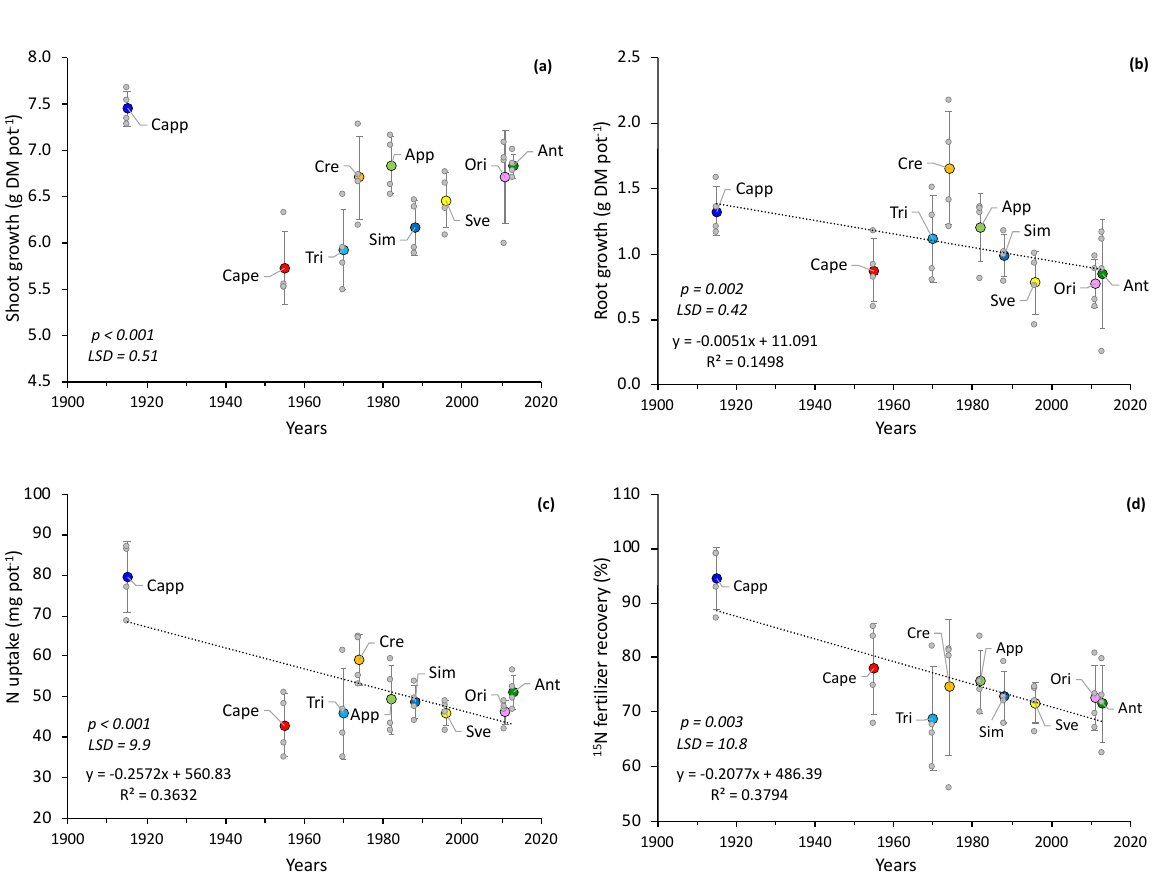
Figure 3. Relationships between shoot growth ( a ), root growth ( b ), N uptake ( c ), and 15 N fertilizer recovery ( d ) 35 days after the application of N fertilizer (Time 3) and the year of release of the nine studied genotypes. For each trait the p value and LSD (Fisher’s LSD test, p = 0.05) are reported. All genotype data are plotted with the mean depicted as a colored circle ± standard deviation ( n = 4) represented by the end of the vertical black line. N, nitrogen; LSD, least significant difference; DM, dry matter.